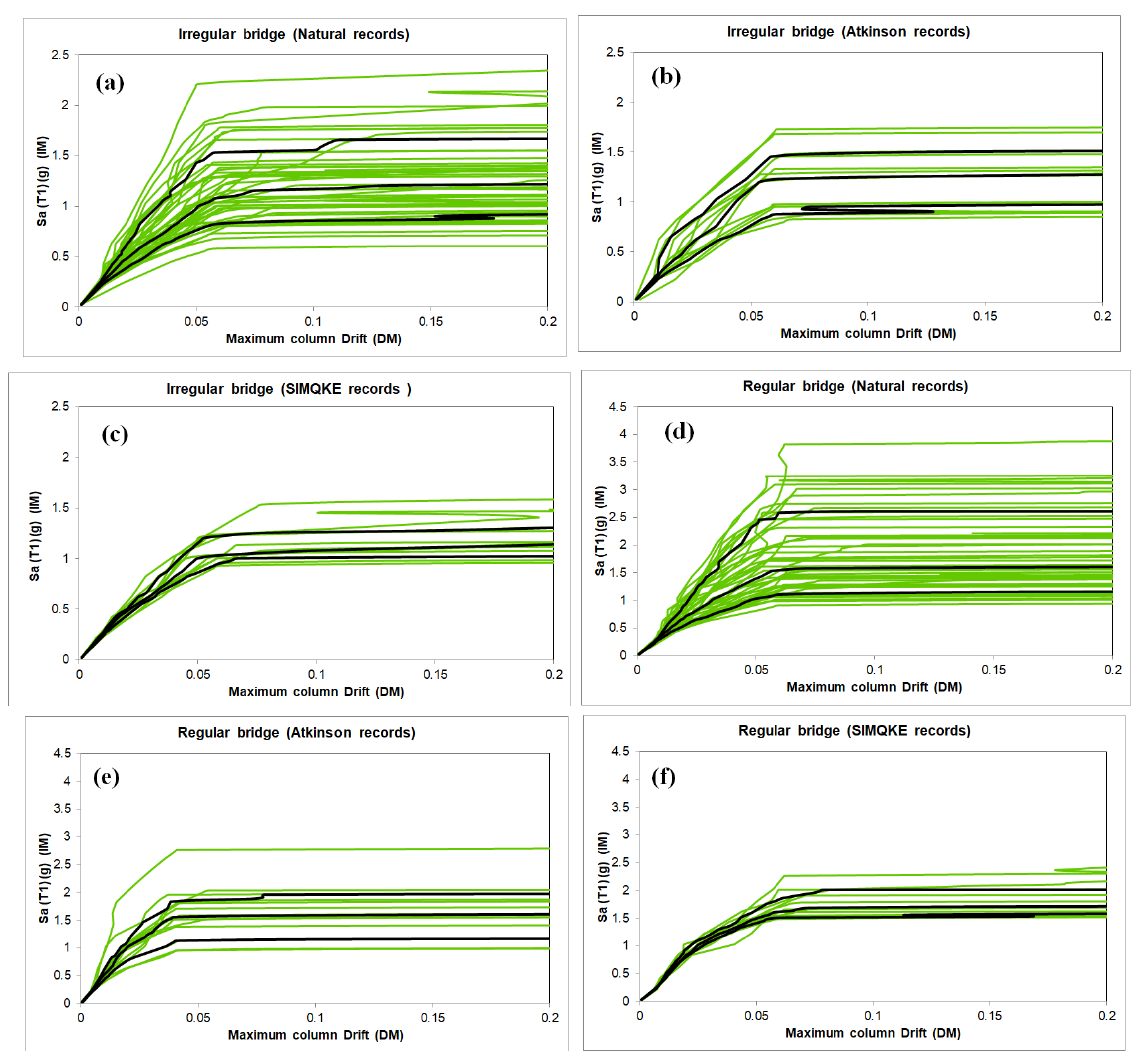
Figure 13. Incremental dynamic analysis (IDA) curves obtained for the irregular bridge using: ( a ) natural, and ( b ) Atkinson and ( c ) SIMQKE records and for the regular bridge using: ( d ) natural, and ( e ) Atkinson and ( f ) SIMQKE records.